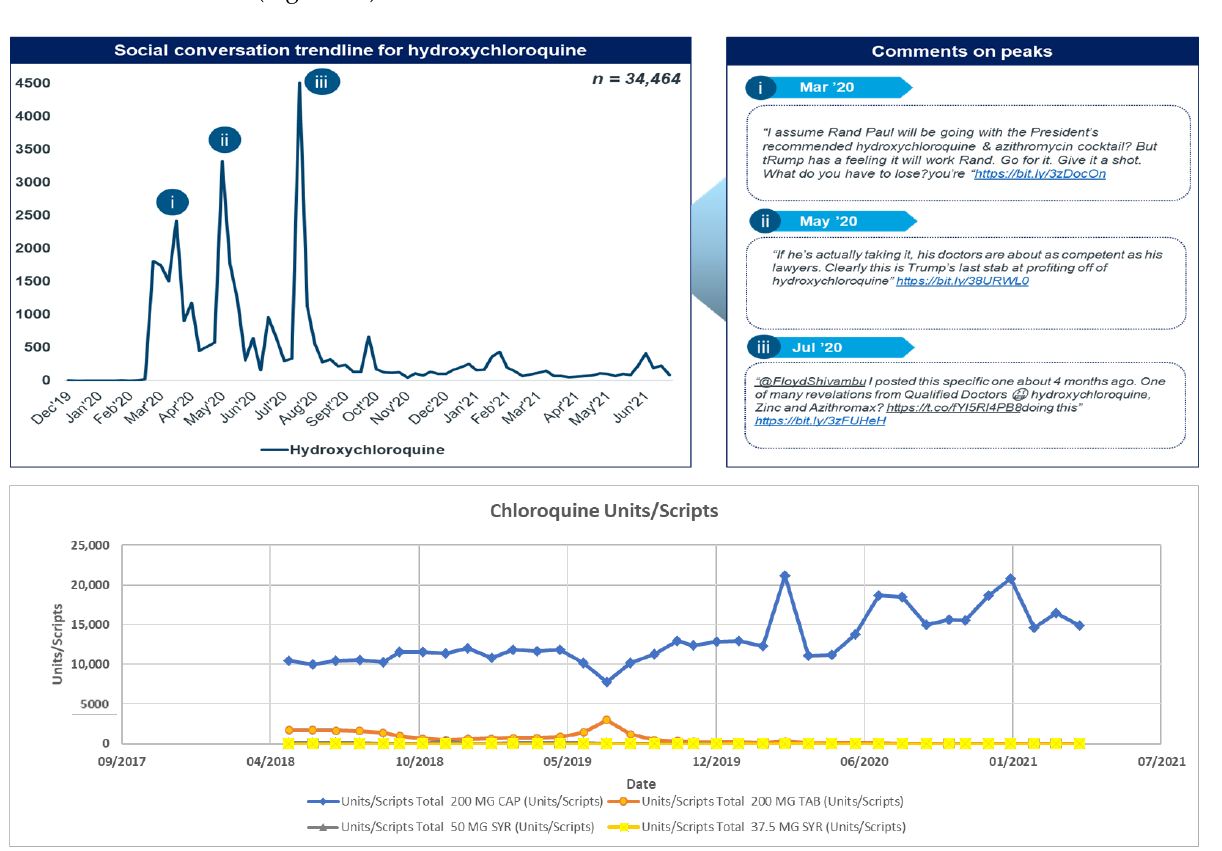
Figure 3. ( A ) Social conversation trendline ( B ) utilisation trendline as units/scripts for chloroquine.